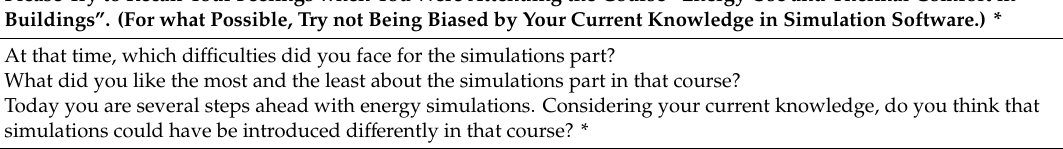
Table A1. Open-ended questions for C2017 and